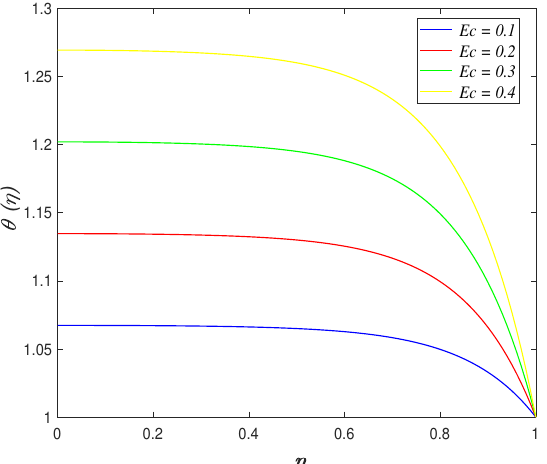
Figure 18. Impact of Ec on temperature.